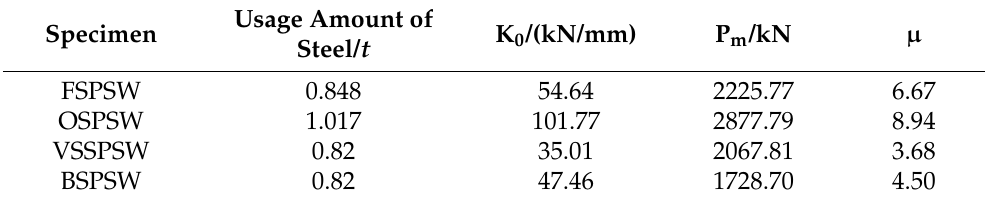
Table 5. Characteristic results and usage amount of steel of specimens.